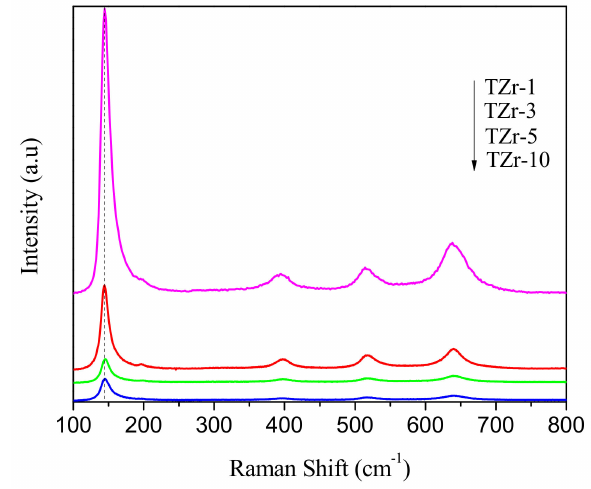
Figure 4. Raman spectra of the Ti–Zr